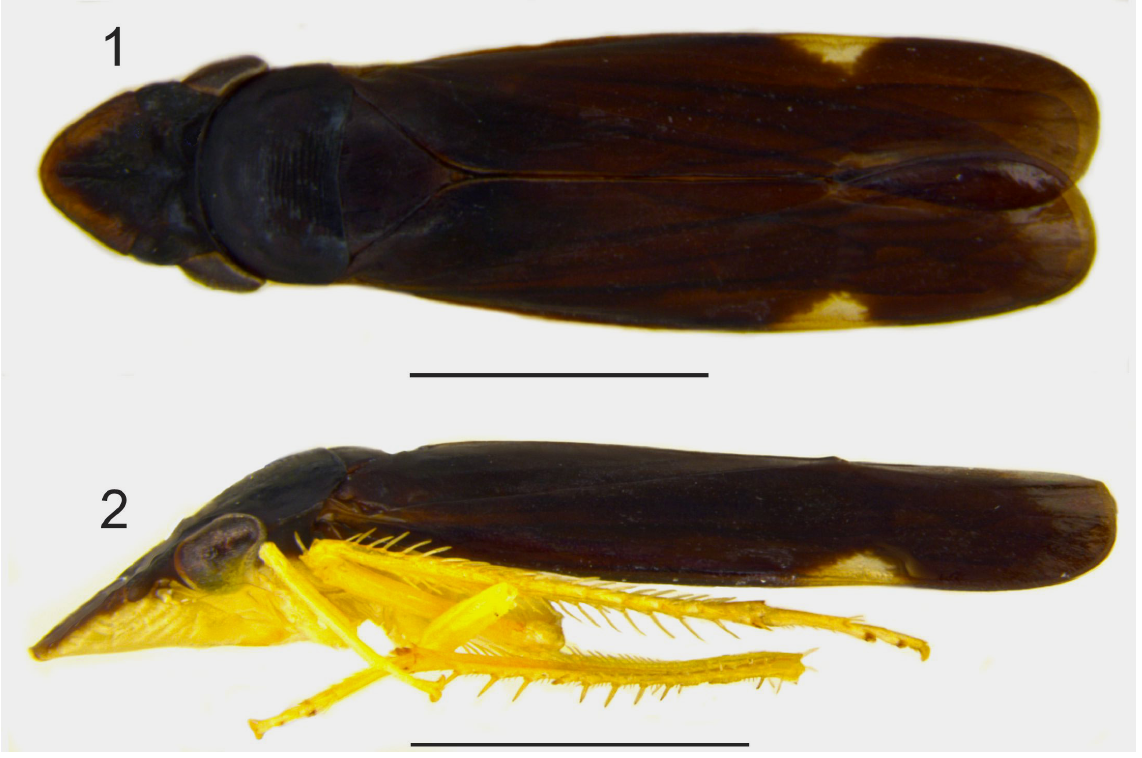
Figs 1–2. Platygonia nigra sp. nov., holotype, ♂ (INPA). 1 . Body, dorsal view. 2 . Body, lateral view. Scale bars = 2